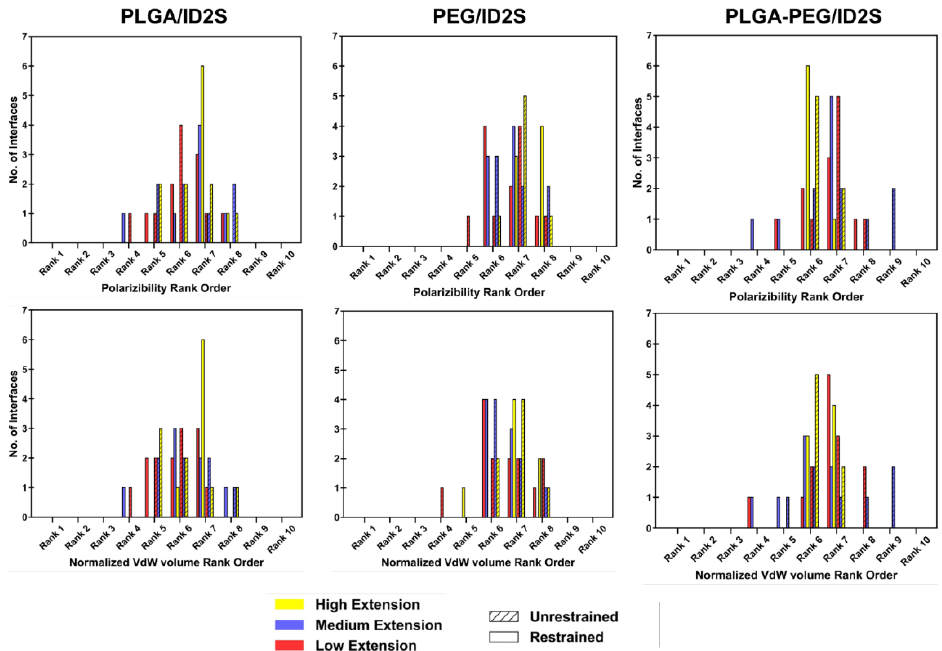
Figure A11. Polarizability and normalized van der Waals volume rank distributions of the collapsed filtered protein – polymer interface for PLGA/ID2S ( left column), PEG/ID2S ( middle column), and PLGA-PEG/ID2S ( right column) systems.